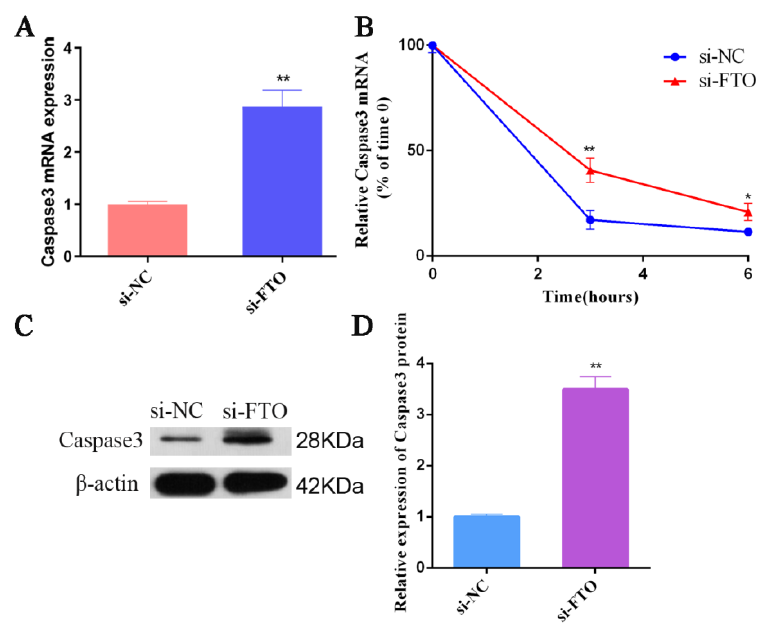
Figure 6. Inhibiting FTO promotes the expression of Caspase 3 in IPEC-J2 cells. ( A ) Upregulation of Caspase 3 mRNA expression after FTO silencing. ( B ) RNA stability assay showing the half-life of Caspase 3 mRNA after silencing of FTO. ( C , D ) Western blotting showing the Caspase 3 protein level after FTO silencing. * p < 0.05; ** p < 0.01. Original western blot figures in Figure S1.